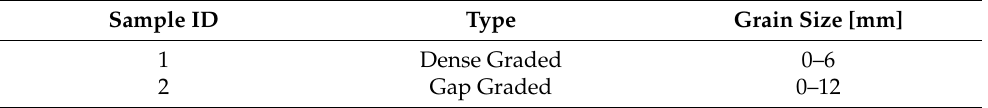
Table 1. Samples